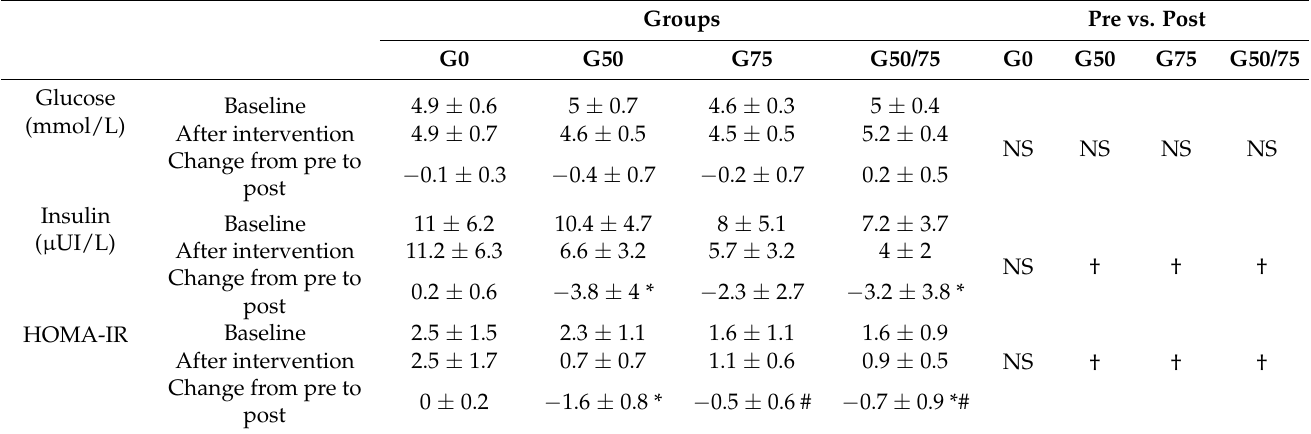
Table 3. Change in biochemical measurements following the 12-week intervention.